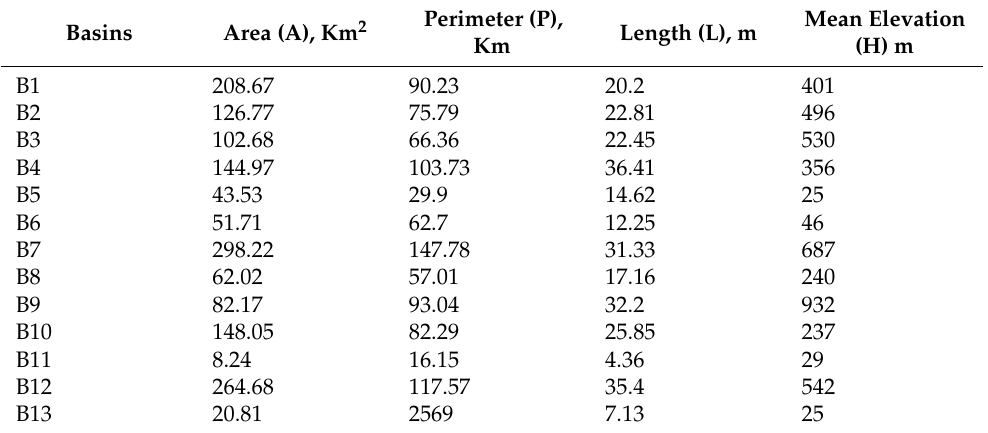
Table 3. Basic morphometric values of the studied